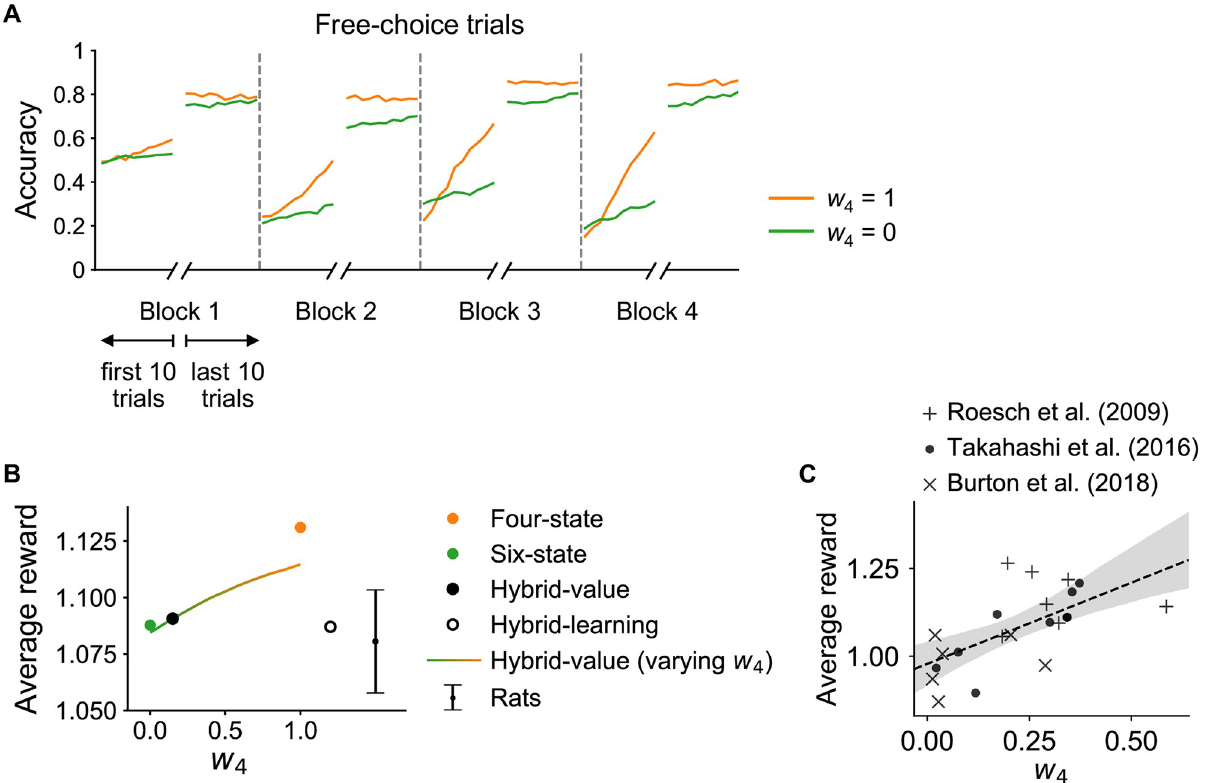
Fig 4. Simulations show faster learning, but a modest increase in reward earned, under the four-state representation. (A) Learning curves for free- choice trials in data simulated using the best-fit parameter values (i.e., posterior mean of the group-level parameters) of the hybrid-value model, but setting w 4 to 1 or 0 (corresponding to the four-state and six-state models, respectively). The four-state model ( w 4 = 1) shows faster learning in each of the blocks and higher asymptotic accuracy than the six-state model ( w 4 = 0). (B) Average amount of reward per trial obtained by the models (dots and curve) and by animals (error bar, mean ± 1 s.e.m.). Dots represent model-simulation results obtained with their best-fit parameter values. The colored curve represents simulation results of the hybrid-value model with its best-fit parameters but varying w 4 from 0 to 1. Average reward earned increases with w 4 , but the differences are relatively small (on the order of 5%). Rats performed, on average, in line with the six-state model and markedly worse than the four-state model. (C) Average reward obtained by each animal is positively correlated with their mean w 4 parameter estimate ( r = 0.64, p = 0.0015). Animals with a state representation more similar to four-state earned more reward on average. Dataset coded by marker